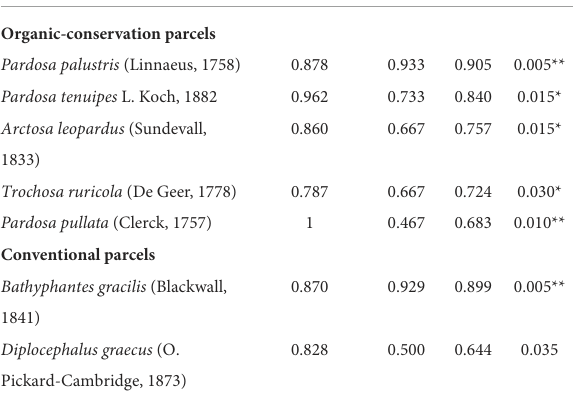
TABLE 3 Specificity and fidelity components of value index (indval) for spiders in organic conservation parcels and conventional ones, last column indicates the significance of the relationship between the species and the targeted system type. Specificity Fidelity Stat P